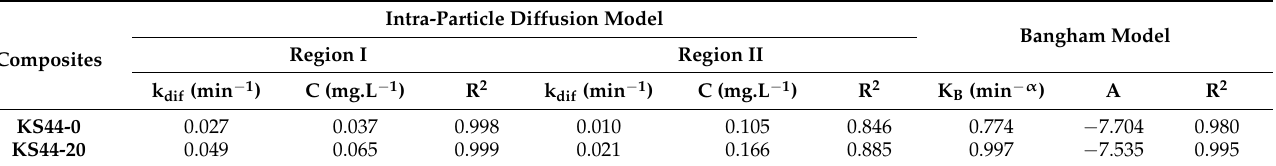
Figure 5. Intra ‐ diffusion kinetic model representation for RhB adsorption on ( a ) KS44 ‐ 0 and ( b ) KS44 ‐ 20.